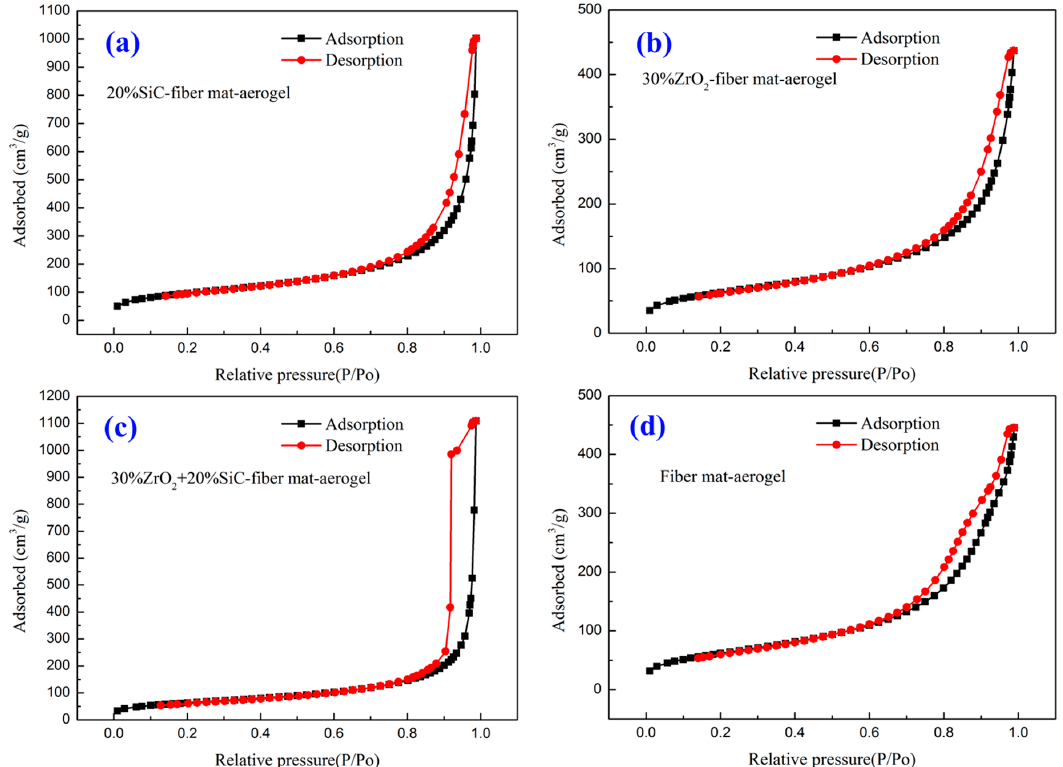
Figure 5. Adsorption and desorption isotherms. ( a ) Sample 2# 20% SiC-fiber mat-aerogel; ( b ) Sample 8# 30% ZrO 2 -fiber mat-aerogel; ( c ) Sample 13# 30% ZrO 2 + 20% SiC-fiber mat; ( d ) Sample 16# Fiber mat-aerogel. Table 2. Specific surface area of aerogel composite.